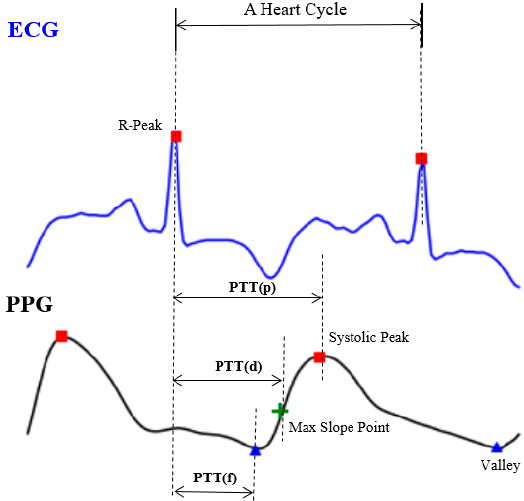
Figure 2. The expedient solution from engineers, including pulse transit time (PTT) (p), PTT (d) and PTT (f).